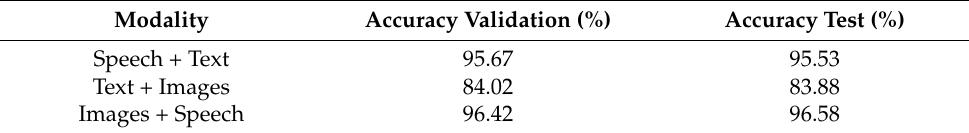
Table 8. Results of bimodal prediction of trust using top 3 performing models.